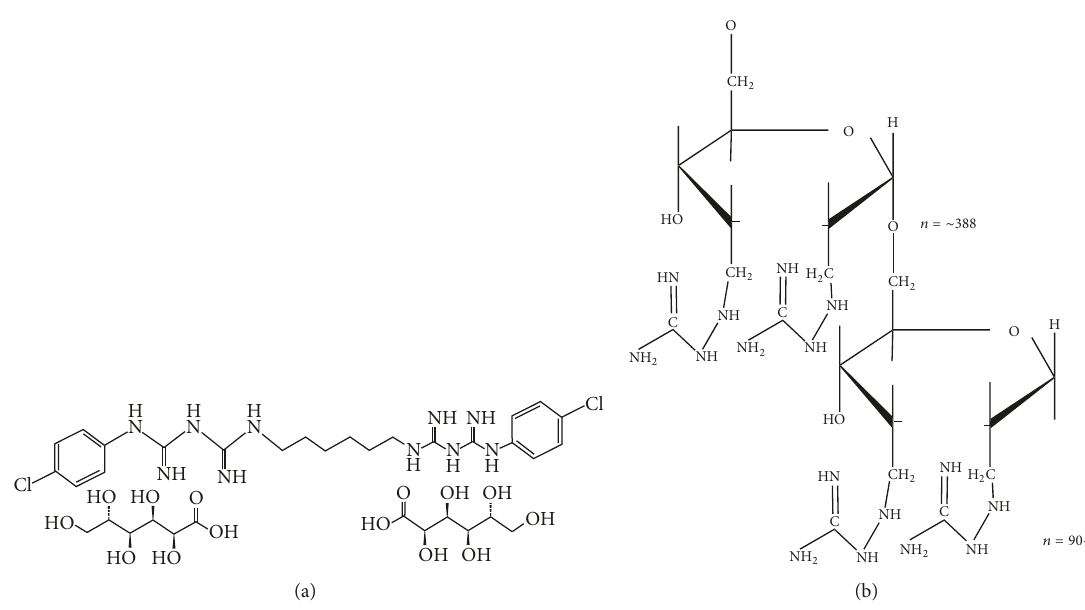
Figure 1: Chemical structure of chlorhexidine gluconate (CHX) (a) and CatDex